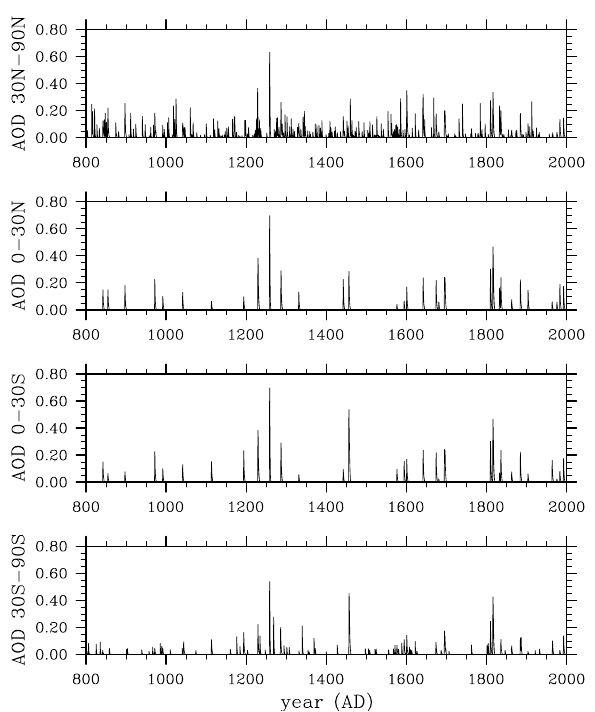
Fig. 18. Reconstructed stratospheric volcanic aerosol optical depth at 550nm since year 800. From Crowley et al. (2008), for four different latitudinal bands.